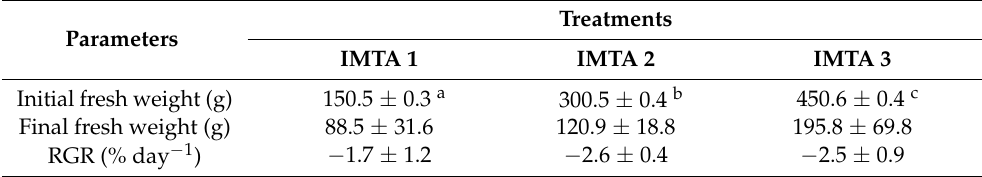
Table 4. Relative growth rates (% day − 1 ) of U. lactuca (mean ± standard deviation) in the IMTA 1 35 days of cultivation.